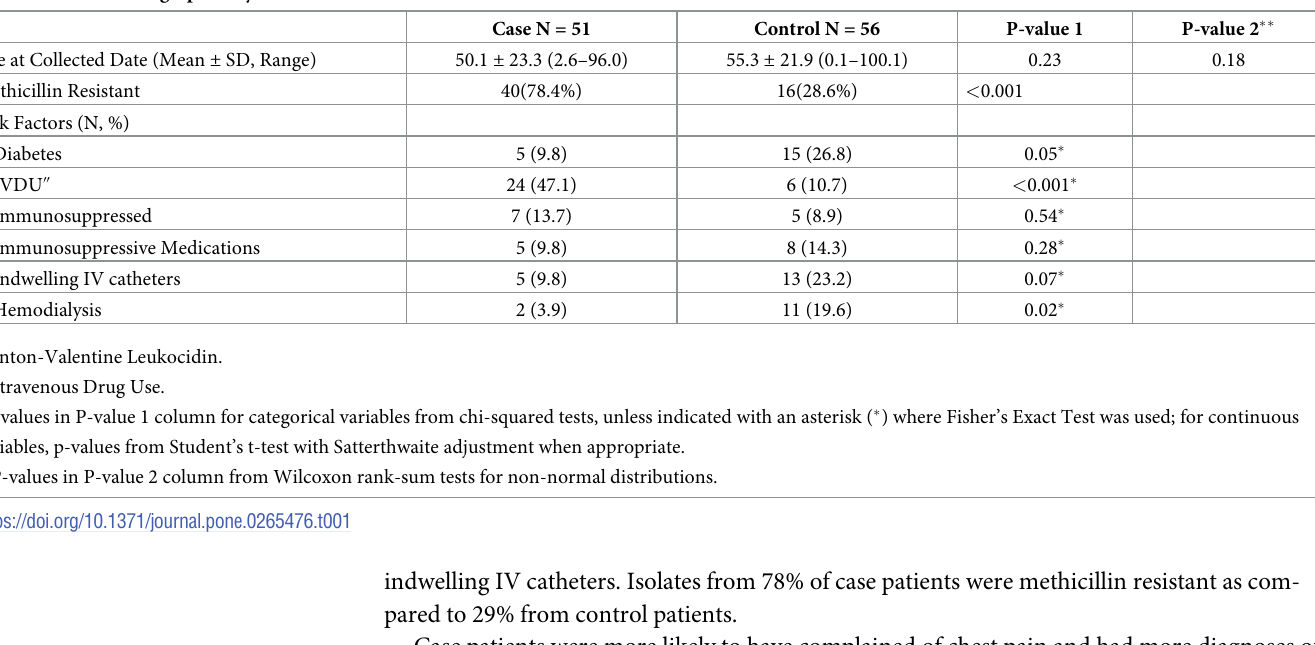
indwelling IV catheters. Isolates from 78% of case patients were methicillin resistant as com- pared to 29% from control patients. Case patients were more likely to have complained of chest pain and had more diagnoses of pneumonia and skin/soft tissue infection, with no differences seen in the incidence of endocar- ditis, osteomyelitis, or septic arthritis (Table 2). Creatinine and alkaline phosphatase were higher among controls compared to cases (Table 3). The percentage of patients who were clinically cured or expired was comparable. No differ- ences in length of stay nor illness severity (by markers such as sepsis or septic shock) had been